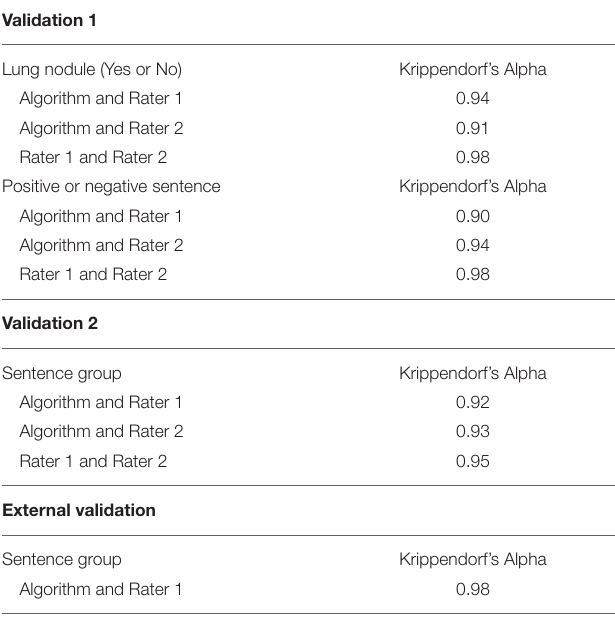
TABLE 2 | Sentence classification inter-reader agreement.